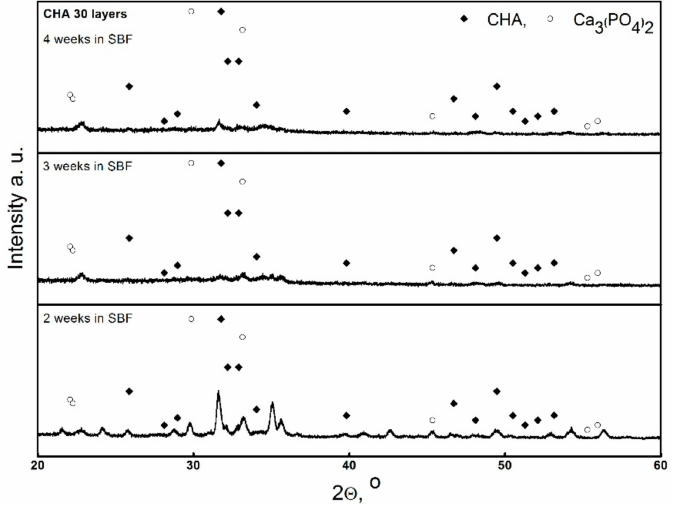
Figure 13. XRD patterns of CHA samples coated with 30 layers after immersion in SBF for 2, 3, and 4